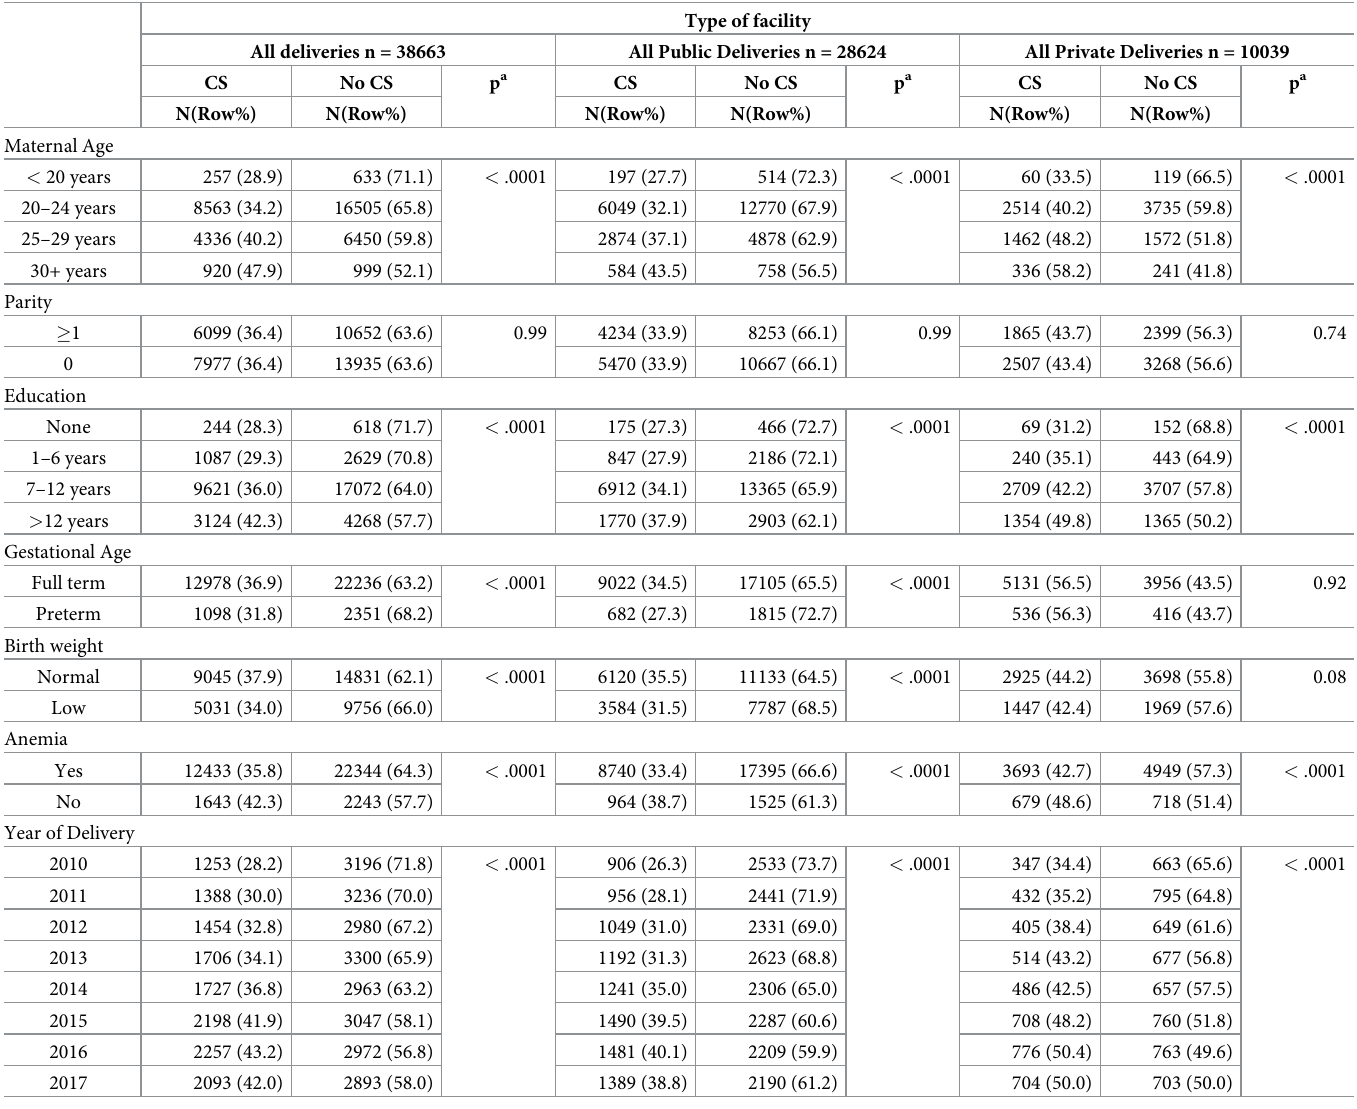
Table 1. Background characteristics of population by type of facility of